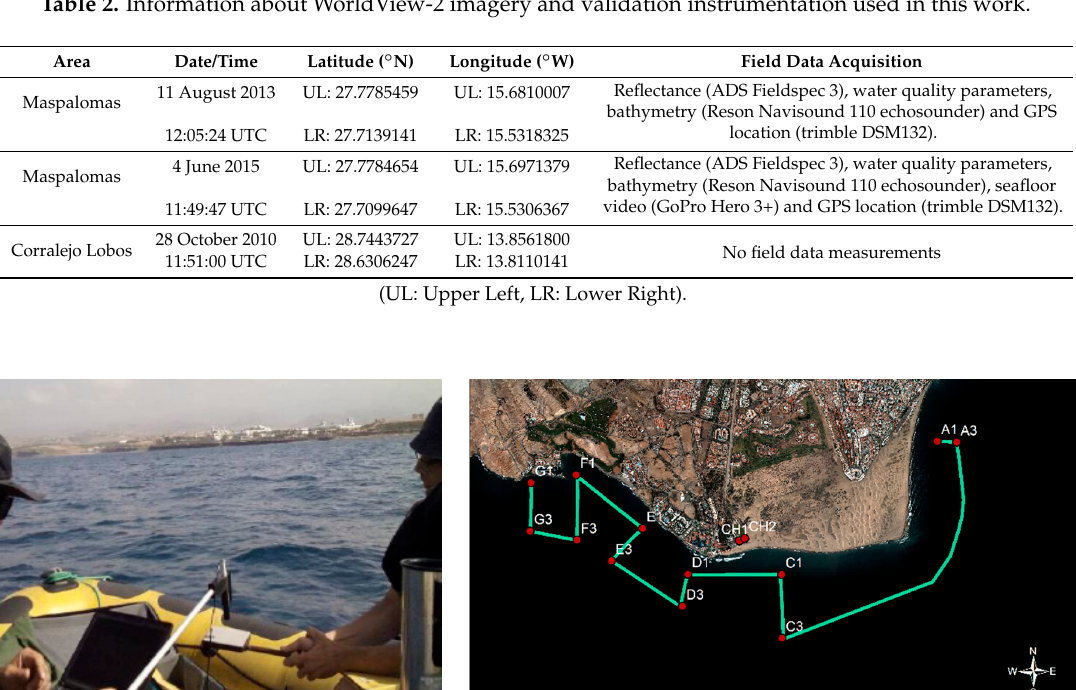
Table 2. Information about WorldView-2 imagery and validation instrumentation used in this work.